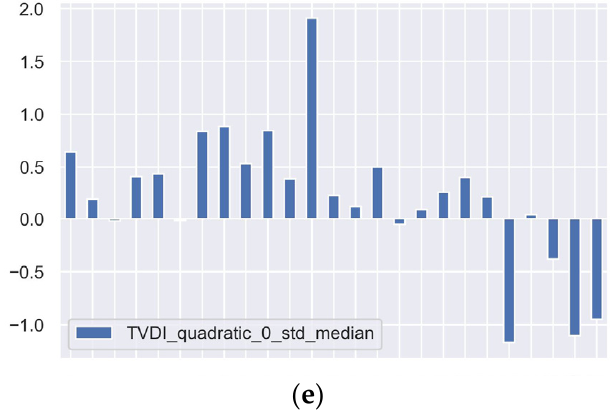
Figure 7. Barplots of the median of standardized calculated indices on 24 August 2019: ( a ) LST, ( b ) NDVI, ( c ) NDBI, ( d ) TVDI , ( e ) qTVDI .